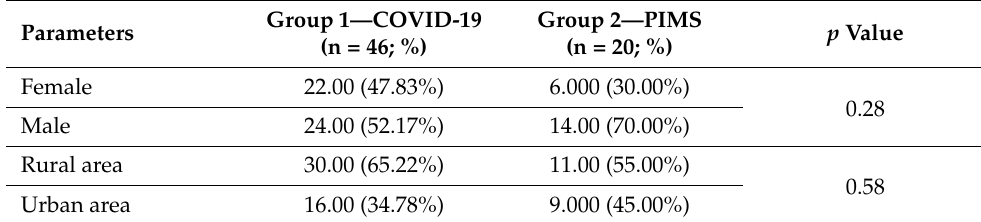
Table 1. Correlation between COVID-19 or PIMS and gender or originating area.